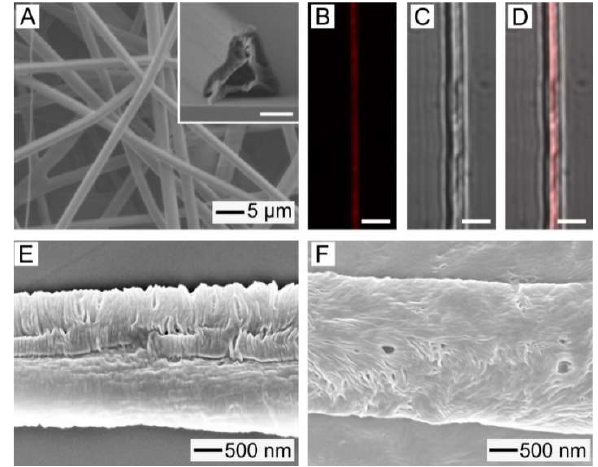
Figure 6. ( A ) SEM image of AuNC-loaded fibers containing the fatty acid mixture and DOX, which were produced using a W/O emulsion of f fatty = 0.05. The inset scale is 1 μm. ( B – D ) CLS micrographs showing the fluorescence from DOX loaded in the as-spun fiber. The scales are 3 μm. ( E , F ) SEM images of AuNC-loaded fibers after exposure to 1 W/cm 2 NIR light. The fibers were made using W/O emulsions of: ( E ) f fatty = 0.05 and ( F ) f fatty = 0.1.